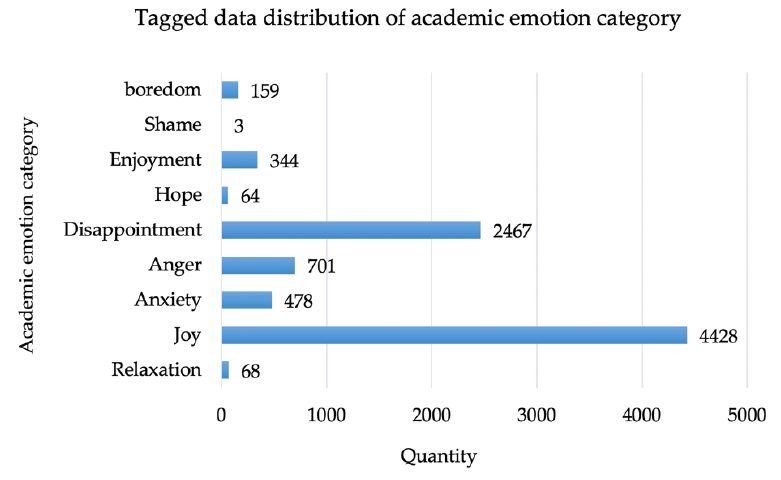
Figure 7. Tagged data distribution picture of academic emotion category.